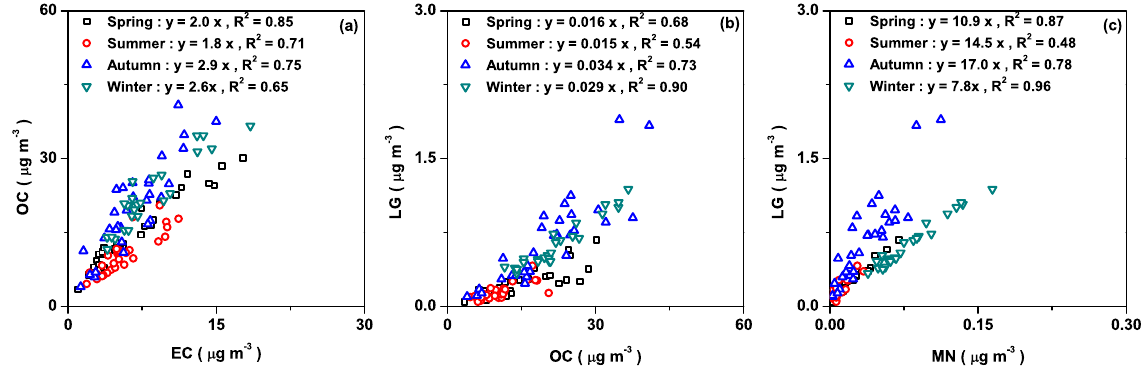
Figure 2. Scatter plots of OC vs. EC (a) , LG vs. OC (b) , and LG vs. MN (c) in four seasons. Also shown are the linear regression lines with regression